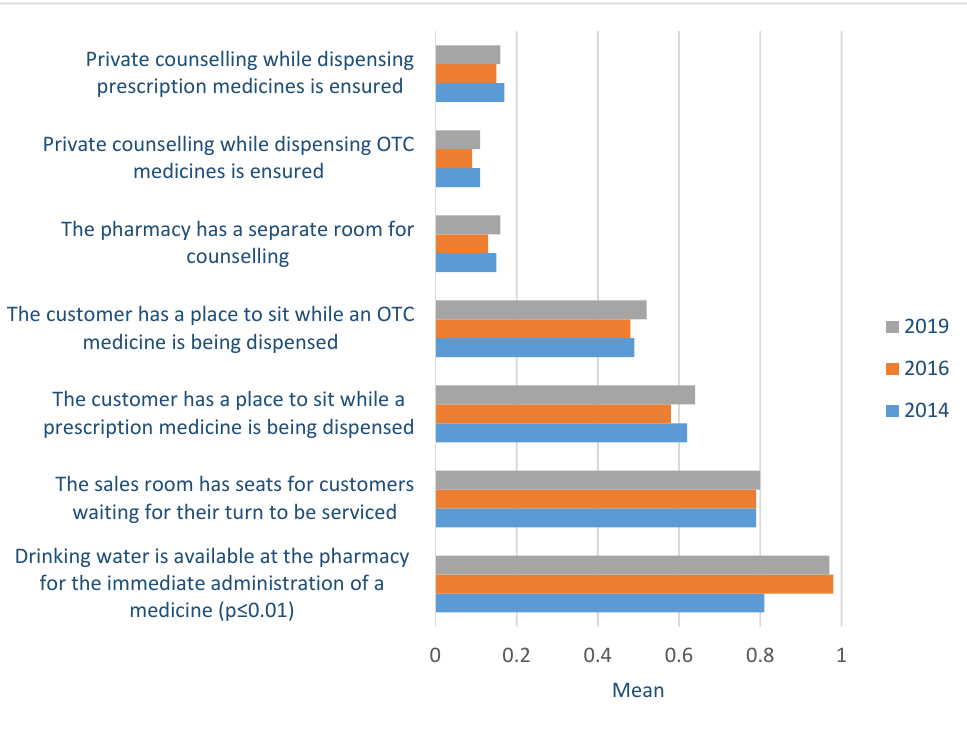
Figure 4. Private counselling availability, seating possibilities, and drinking water for pharmacy customers at community pharmacies based on the evaluation of the Community Pharmacy Service Quality Guidelines (two-point scale) in 2014-19.